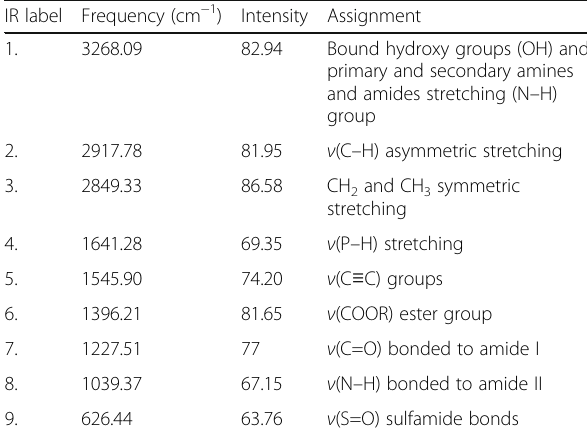
Table 1 Functional groups of Lactococcus lactic subsp. lactis treated with cholesterol and the corresponding infrared absorption frequencies